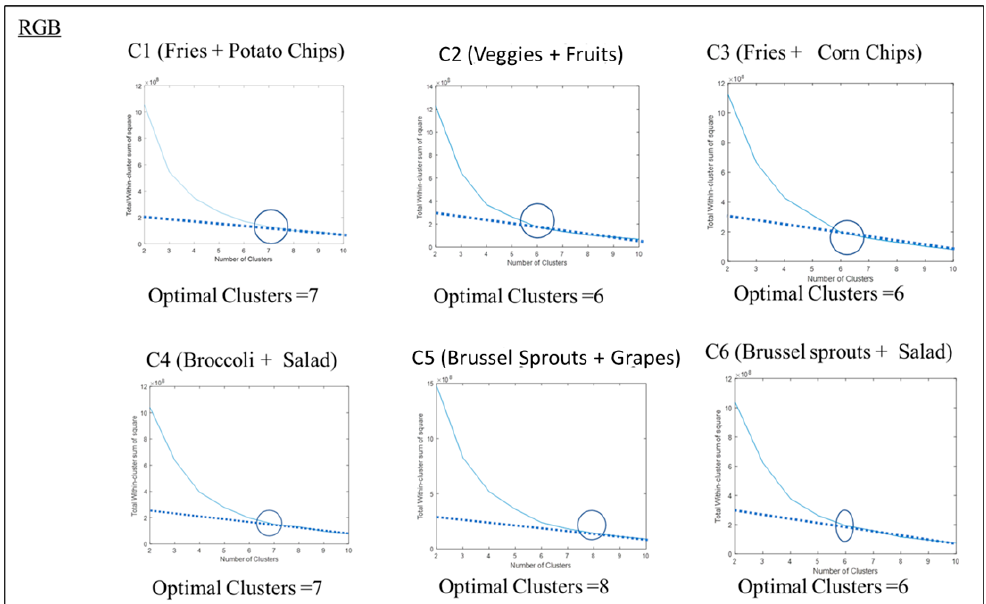
Figure A1. WSS Optimization scheme to determine the number of optimal clusters in RGB-T data.